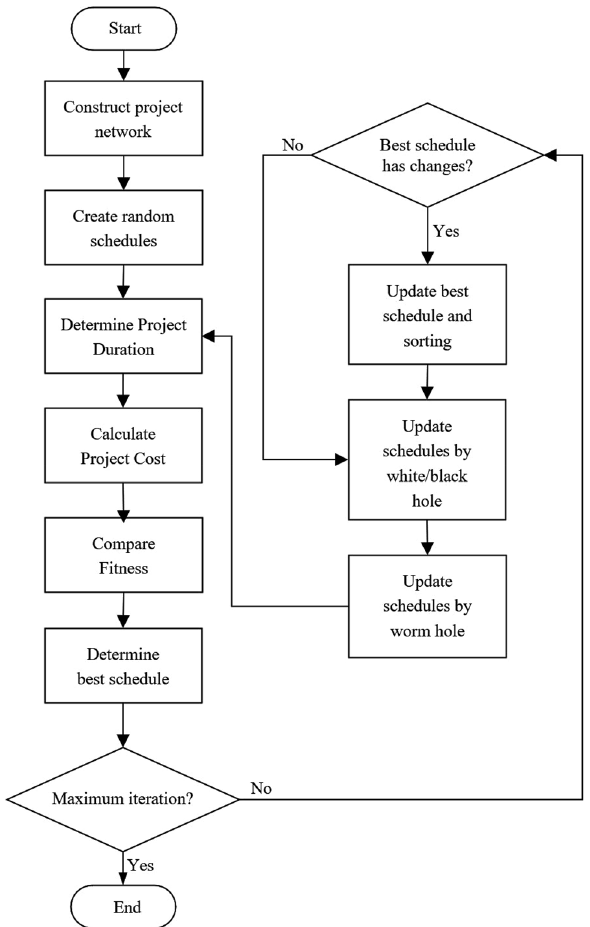
Figure 6. Flowchart of the proposed hDMVO